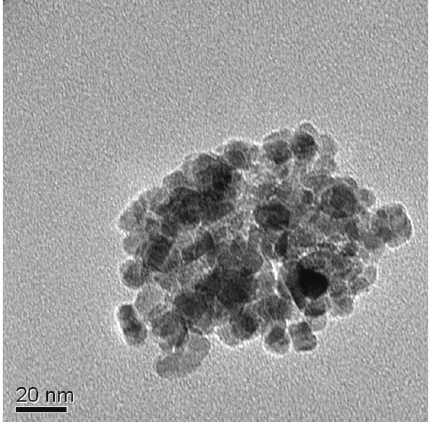
Figure 2: TEM images of Fe 3 O 4 particles